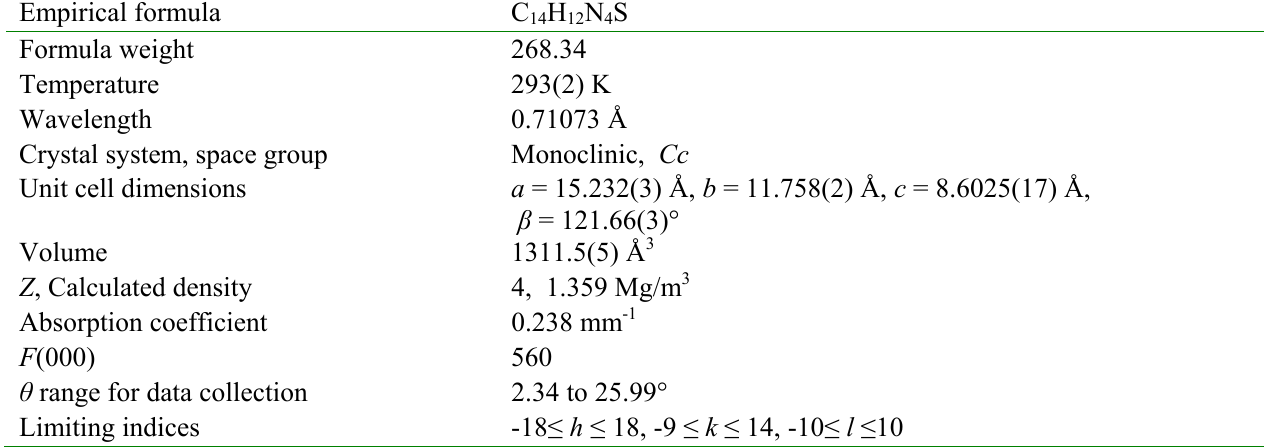
Table 7 . Summary of crystallographic results for the title